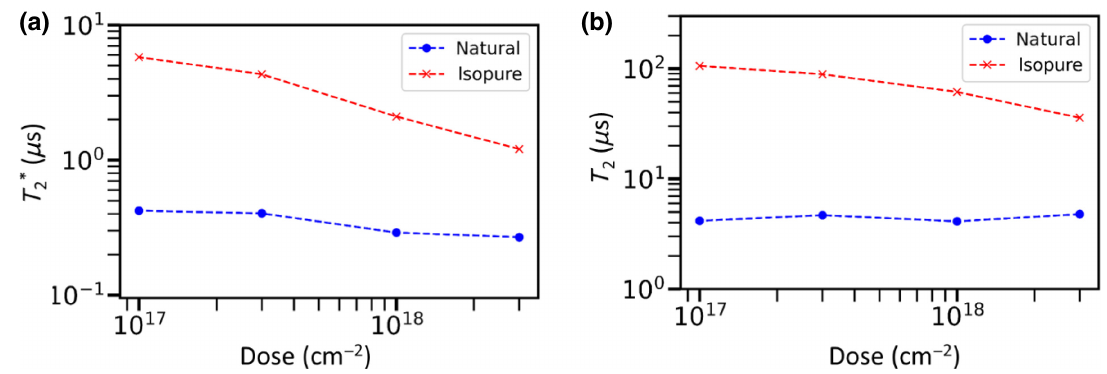
FIG. 4. Dose dependence of T ∗ and T 2 in m s = { 1 / 2, 3 / 2 } basis. (a) Inhomogeneous dephasing time T ∗ 2 all eight samples. (b) Hahn echo decay time T 2 for all eight